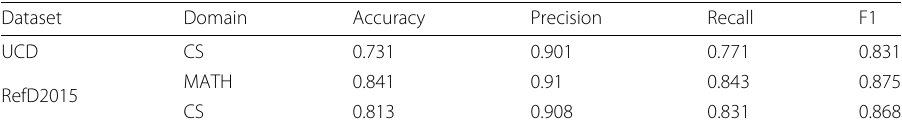
Table 2 Supervised Model Evaluation Dataset